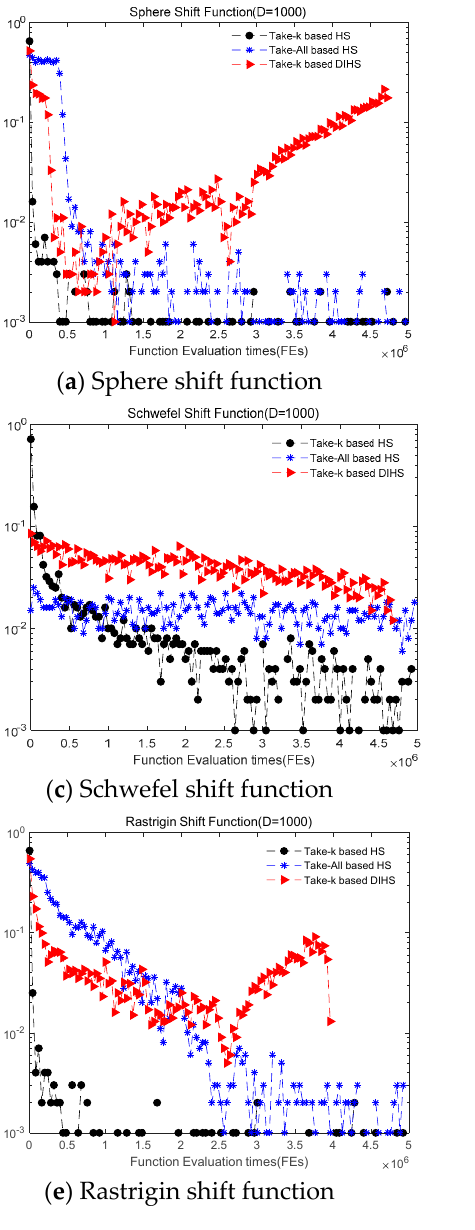
Figure 7. Update success rate of the algorithms for six classical high-dimensional optimization problems. Table 2 summarized the test results of six algorithms (take-all-based HS, take-k-based HS, SaDE